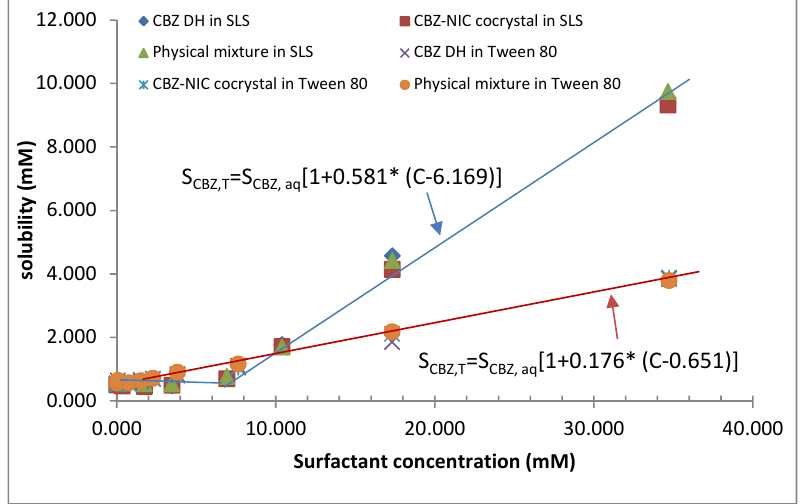
Figure 2. Apparent solubility of CBZ as a function of surfactant concentration.